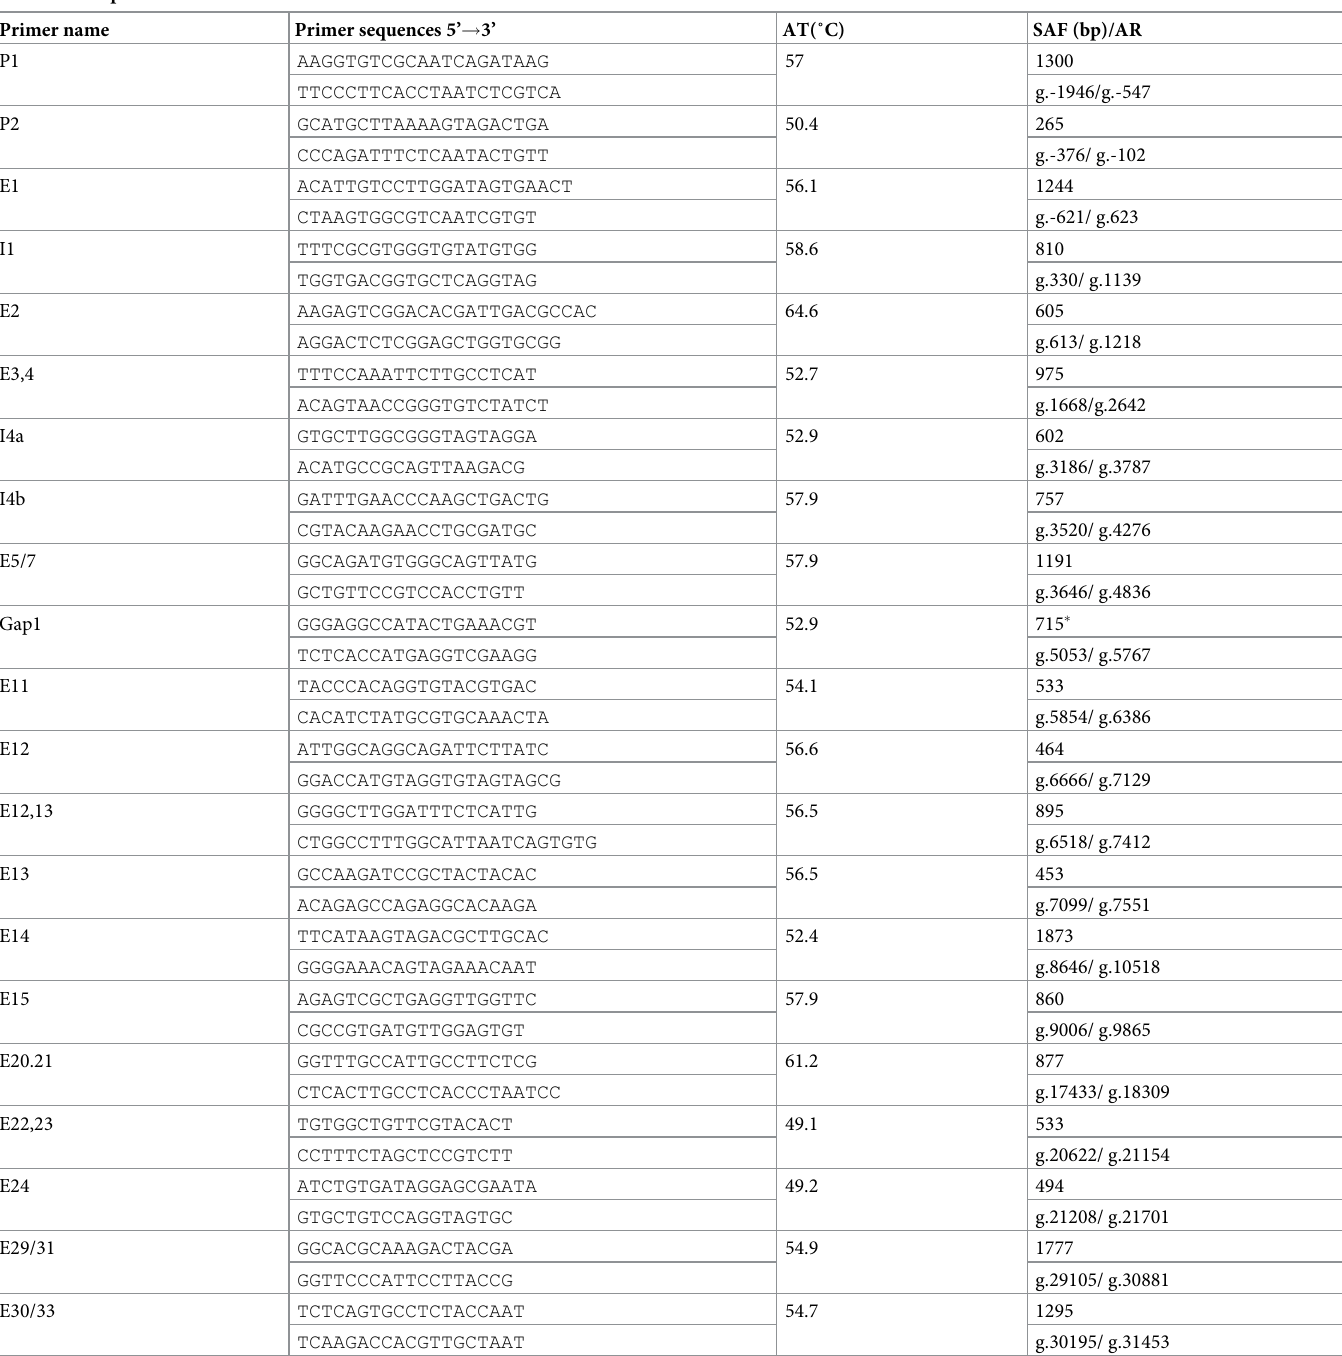
Table 1. The primers to detect the SNPs. Primer